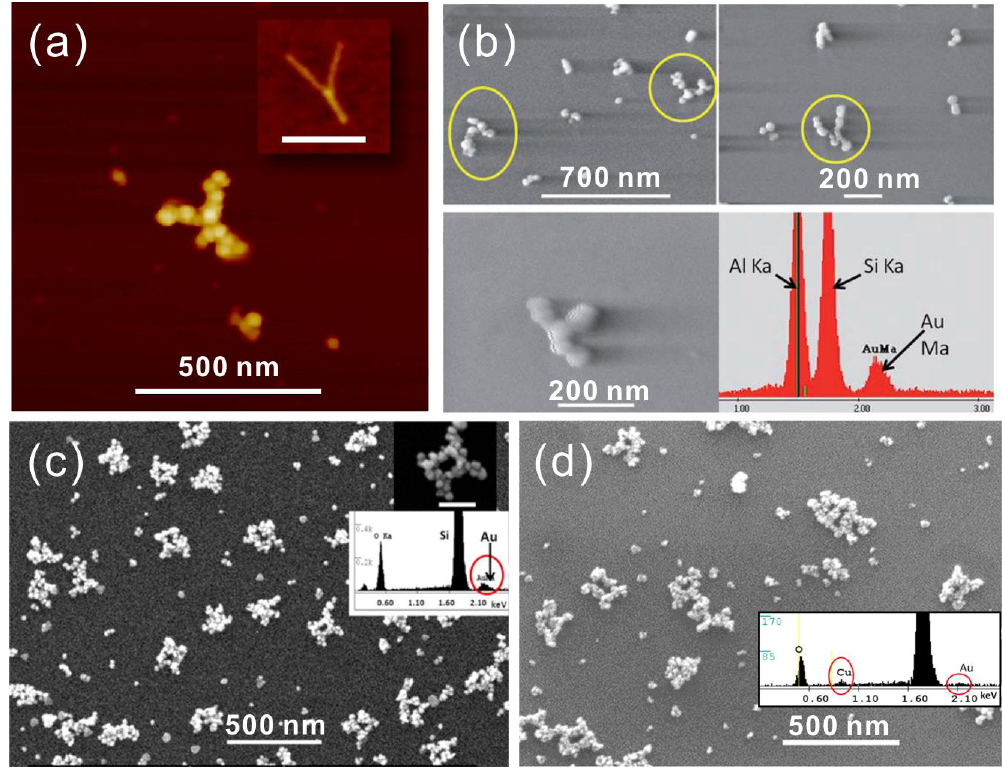
Figure 3. ( a ) AFM image of a Y-shaped DNA origami metallized with Au on mica. The origami shape before metallization is presented in the inset (scale bar 200 nm) [88]. ( b ) DNA origami seeded with Pd 2+ and metallized with Au and the corresponding EDX results [89]. ( c , d ) A circuit-like DNA origami metallized with Au (c) and Cu (d) with respective EDX as the inset [90]. (a) is reproduced with permission from [88]. Copyright American Chemical Society, 2011; (b) is reproduced with permission from [89]. Copyright Royal Society of Chemistry, 2011; (c,d) are reproduced with permission from [90]. Copyright American Chemical Society, 2013.